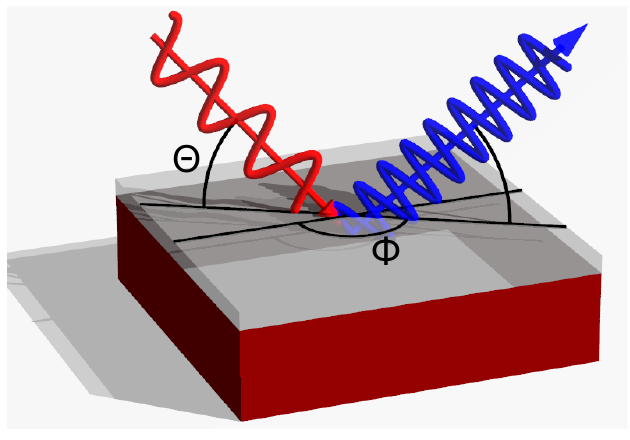
Figure 7. Experimental setup for measuring the second harmonic signal in reflection. The fundamental beam (red) irradiates the sample at an angle Θ , the SH beam (blue) is detected at the opposite angle. By rotating the sample azimuthally by the angle φ the influence of the lattice structure on the SH signal can be